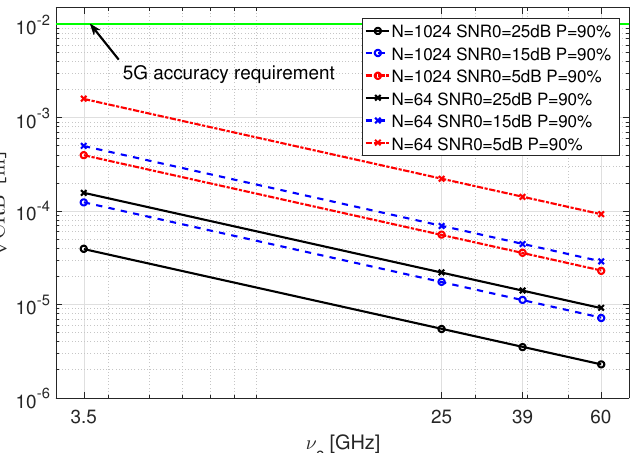
√ CRB vs. ν c for a Gaussian sequence and B = 100 MHz, for different